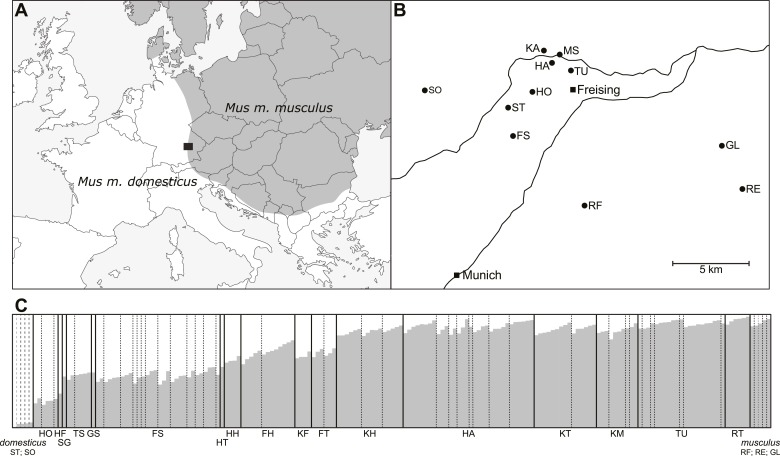
Geographic location of and genetic makeup of mapping population.(A) Location of sampling area (black box) in European house mouse hybrid zone. (B) Sampling locations for parents of mice in the mapping population. (C) Structure analysis of mapping population. Individuals (vertical bands) are arranged by geographic origin and average percentage alleles from Mus musculus musculus.